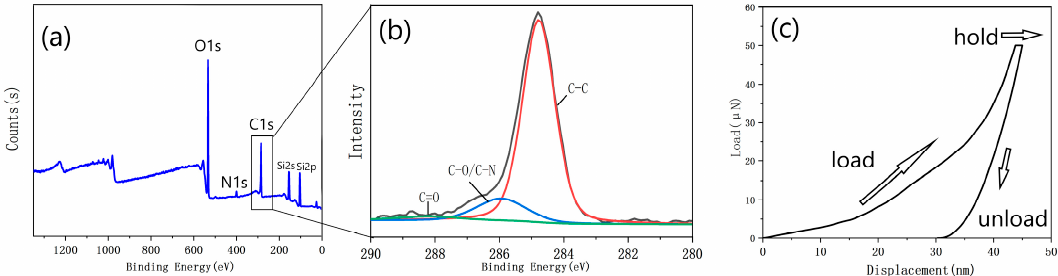
Figure 11. ( a ) XPS spectrum of the film with the optimized parameters; ( b ) the C1s peak of the XPS spectrum; ( c ) a representative load vs. displacement curve obtained from the thick sample.